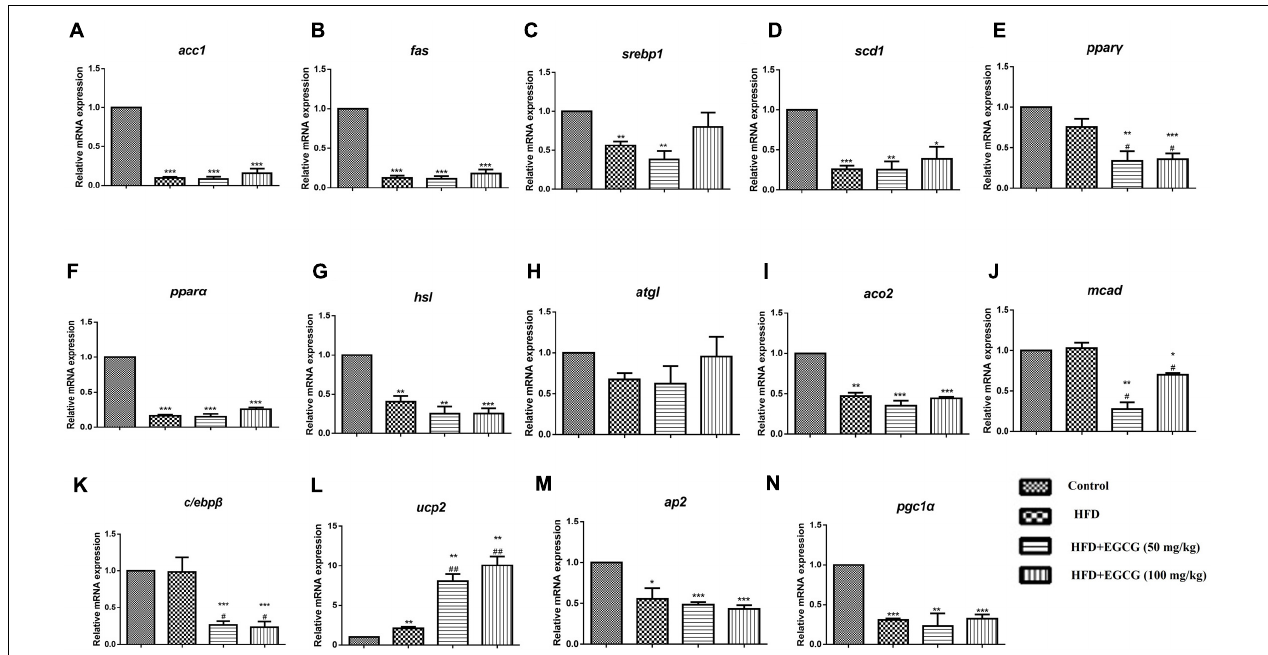
FIGURE 5 | Effect of EGCG on the expression of genes involved in lipogenesis, oxidation, and transportation in epididymal adipose tissues of mice. Total RNA extracted from subcutaneous white adipose tissue was used for mRNA expression analysis of genes involved in fatty acid synthesis [ (A–E) acc1 , fas , srebp1 , scd1 , and ppar γ ], lipolysis [ (F–J) ppar α , hsl , atgl , aco2 , and mcad ], adipocypte differentiation transportation, and thermogenesis [ (K–N) c/ebp β , ap2 , ucp2 , and pgc1 α ]. Values are the mean ± SEM ( n = 3–4). ∗ P < 0.05; ∗∗ P < 0.01; ∗∗∗ P < 0.001 vs. control. # P < 0.05; ## P < 0.01; ### P < 0.001 vs.